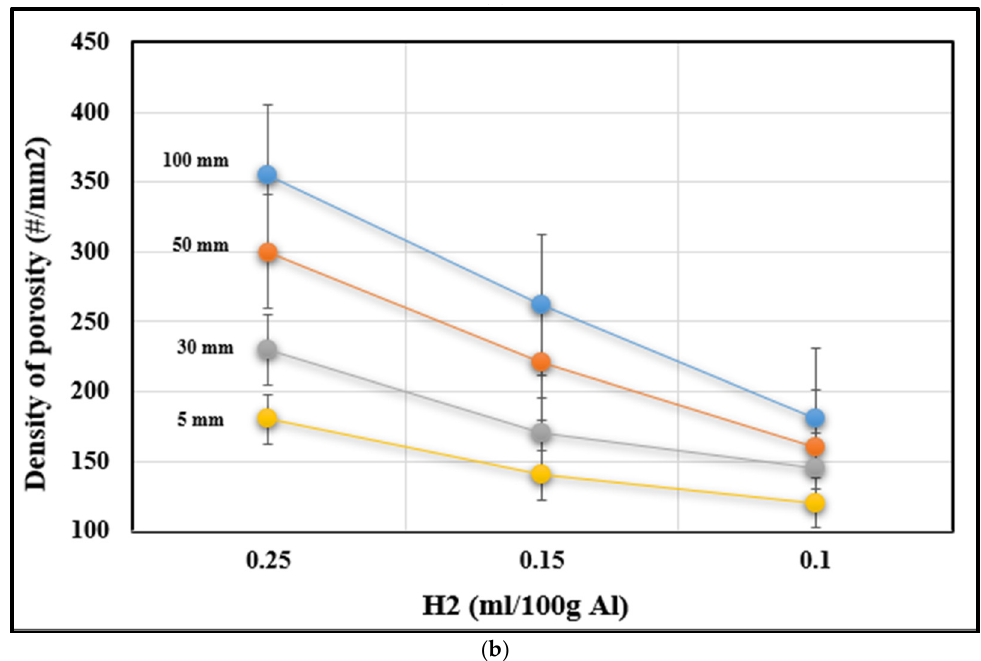
Figure 16. Variation in ( a ) porosity percentage and ( b ) density of porosity as a function of distance from the chill end.